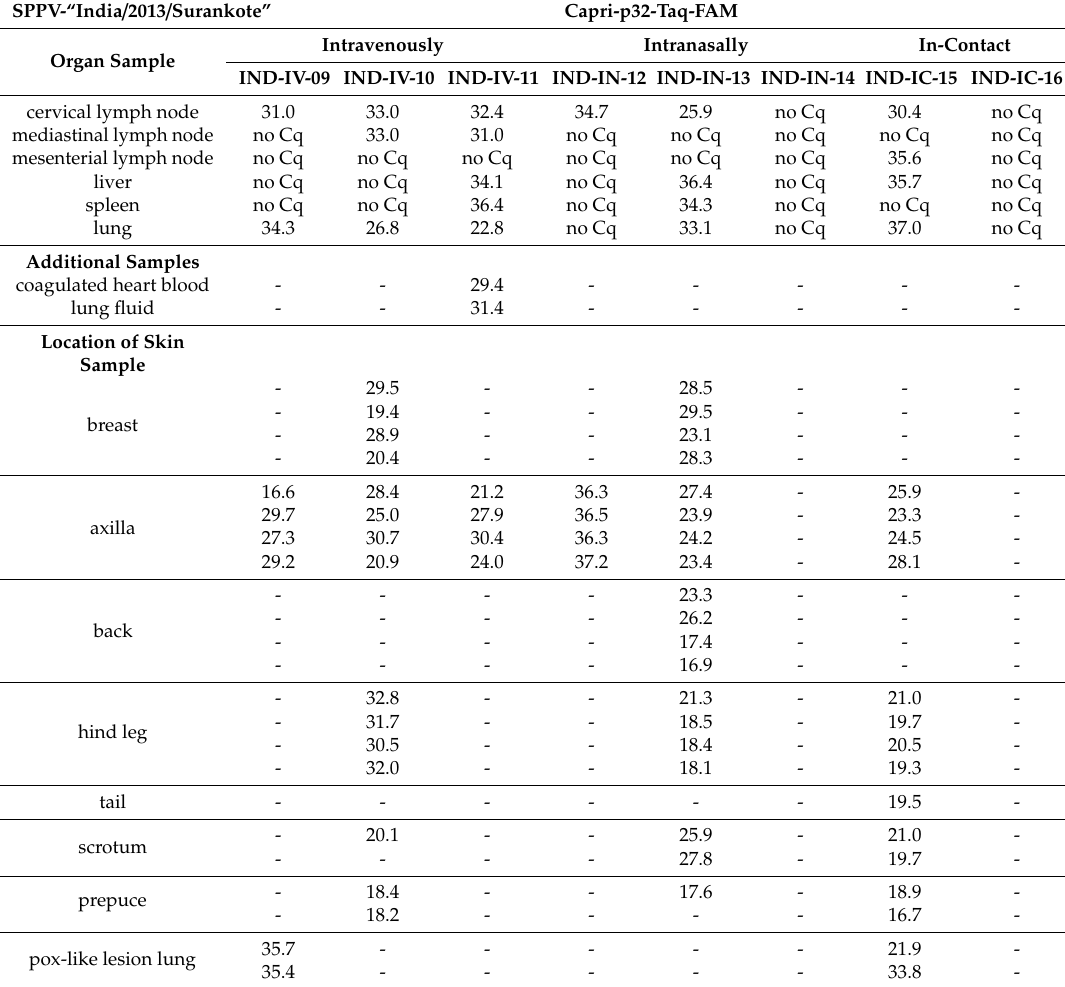
Table 4. Viral genome load (Cq-values) of di ff erent organ samples taken during necropsy after experimental infection of sheep with SPPV-“India / 2013 /